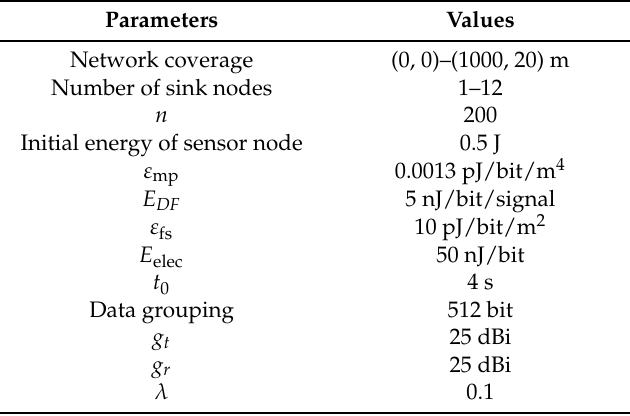
Table 2. Simulation